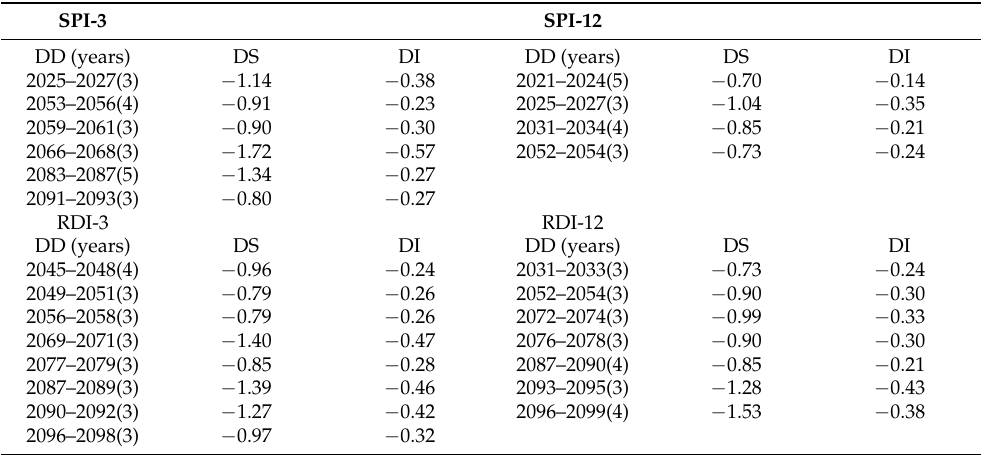
Figure 4. SPI and RDI drought trends at 3 months and 12 months under RCP 4.5. ( a ) SPI drought trends at 3 and 12 month; ( c ) RDI drought trends at 3 and 12 month; ( b ) SPI and RDI drought trends at 12 month ( d ) SPI and RDI drought trends at 3 month. Table 5. Drought duration (DD), drought severity (DS), and drought intensity (DI) under RCP